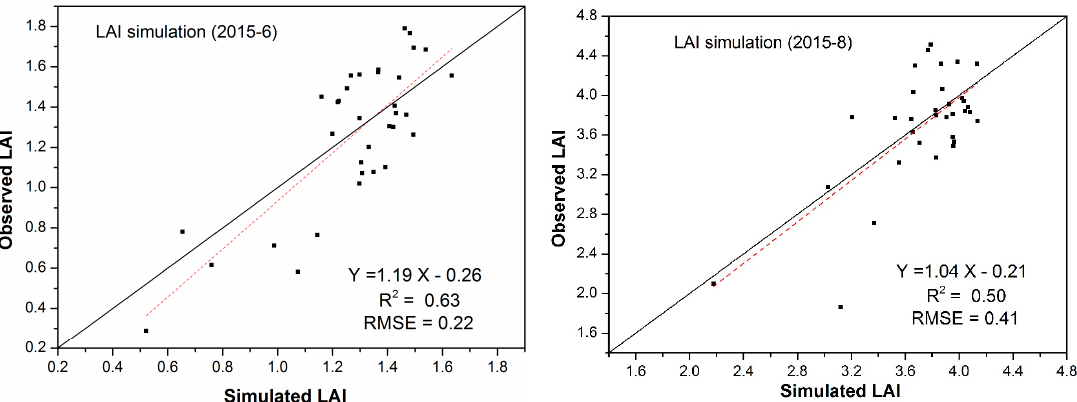
Figure 9. LAI simulation results from the RS-based WOFOST model.